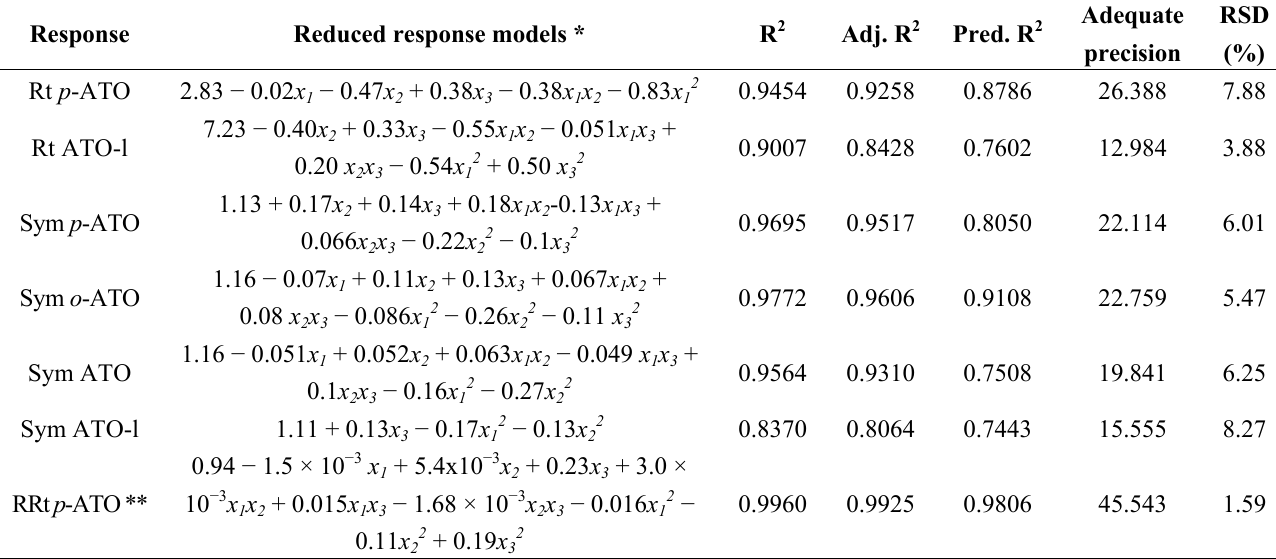
Table 3. Reduced response models and statistical data obtained from ANOVA (after backward